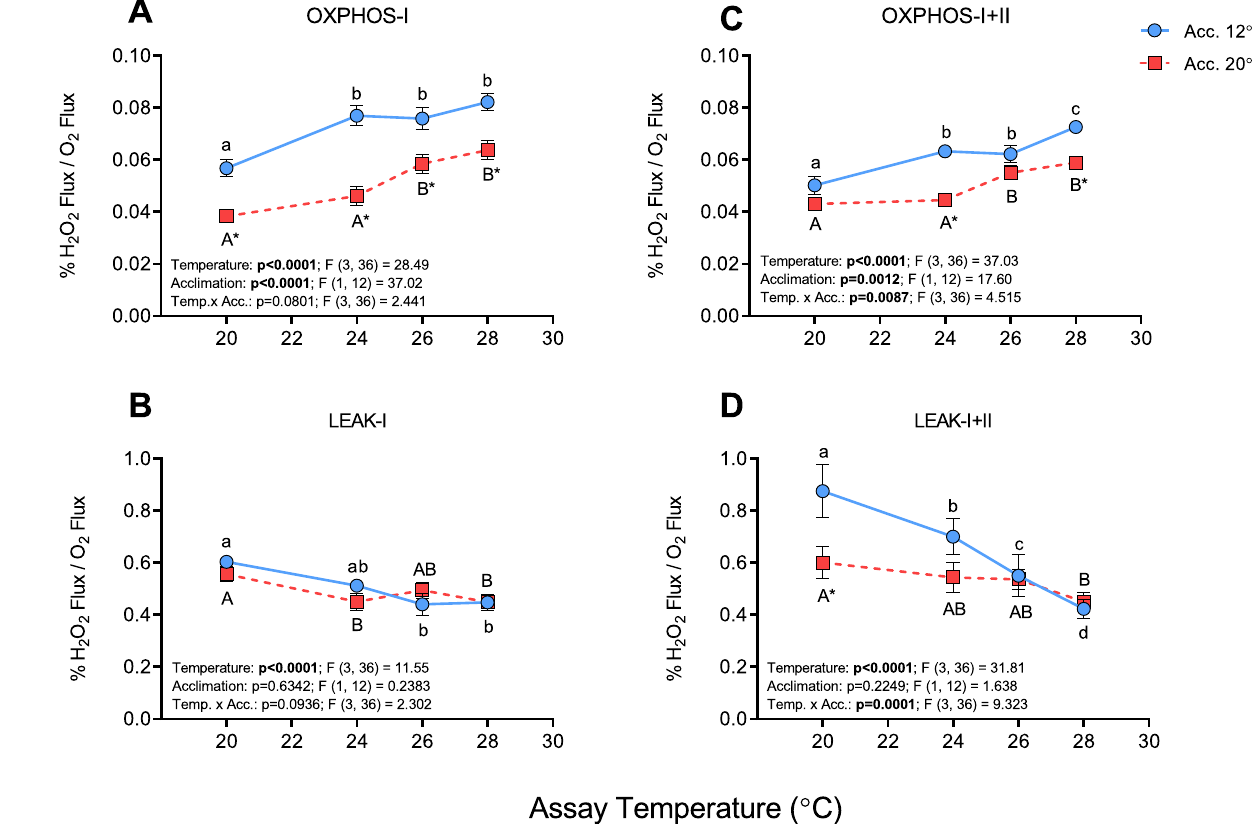
Figure 2. ROS release by cardiac mitochondria from cold- (12 °C) and warm- (20 °C) acclimated salmon when measured at 20, 24, 26 and 28 °C. ROS release is expressed as a percentage of O 2 consumption (% H 2 O 2 flux/ O 2 flux) measured during oxidative phosphorylation (OXPHOS with ADP [100 μmol L −1 ]; A , C ) and LEAK ( B , D ) respiration through complex I ( A , B ; with glutamate and malate as substrates) and complexes I + II ( C , D ; with glutamate, malate and succinate as substrates). An asterisk (*) indicates a significant (P < 0.05) difference between acclimation groups within an assay temperature, whereas letters (a, A) indicate a significant difference between assay temperatures within an acclimation group. Values are means ± s.e.m., N = 7 per